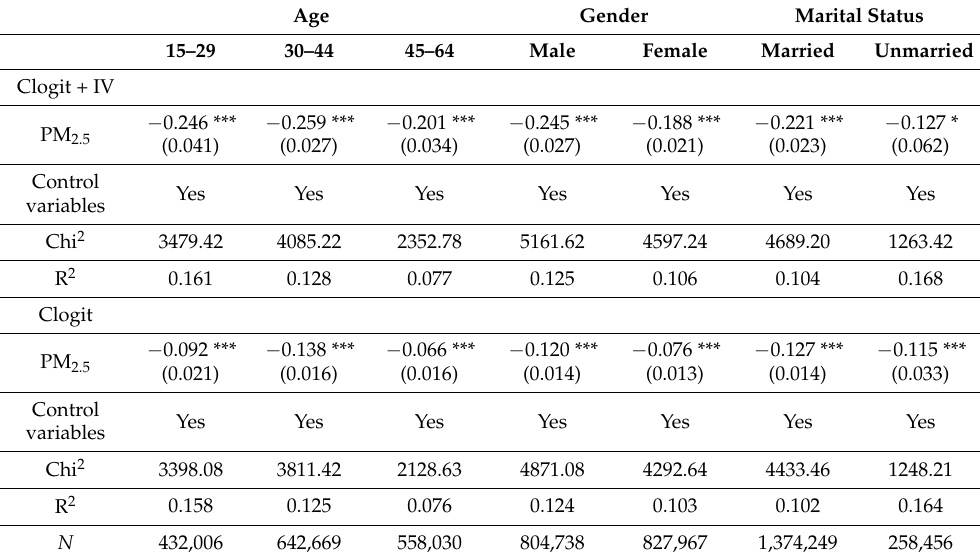
Table 6. Individual heterogeneity: age, gender, marriage.